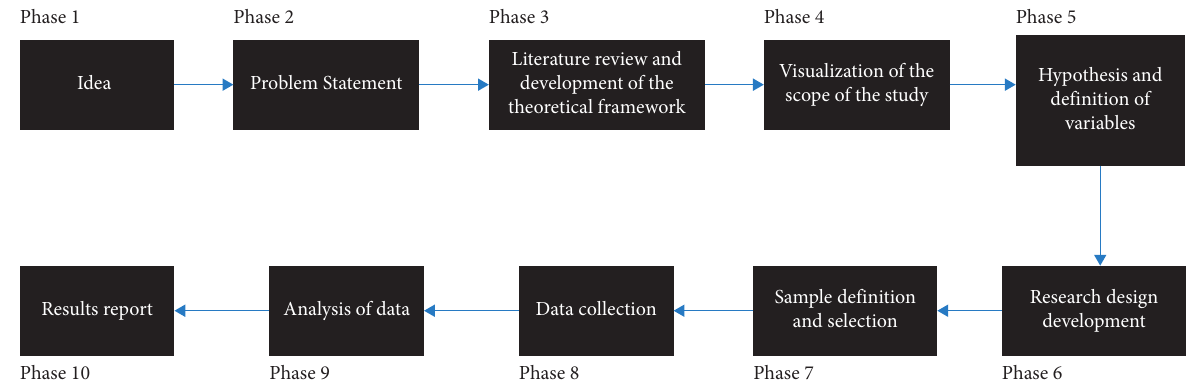
Figure 2: Quantitative research process. Source: Hern´andez, Fern´andez, and Baptista [22], p. 38.